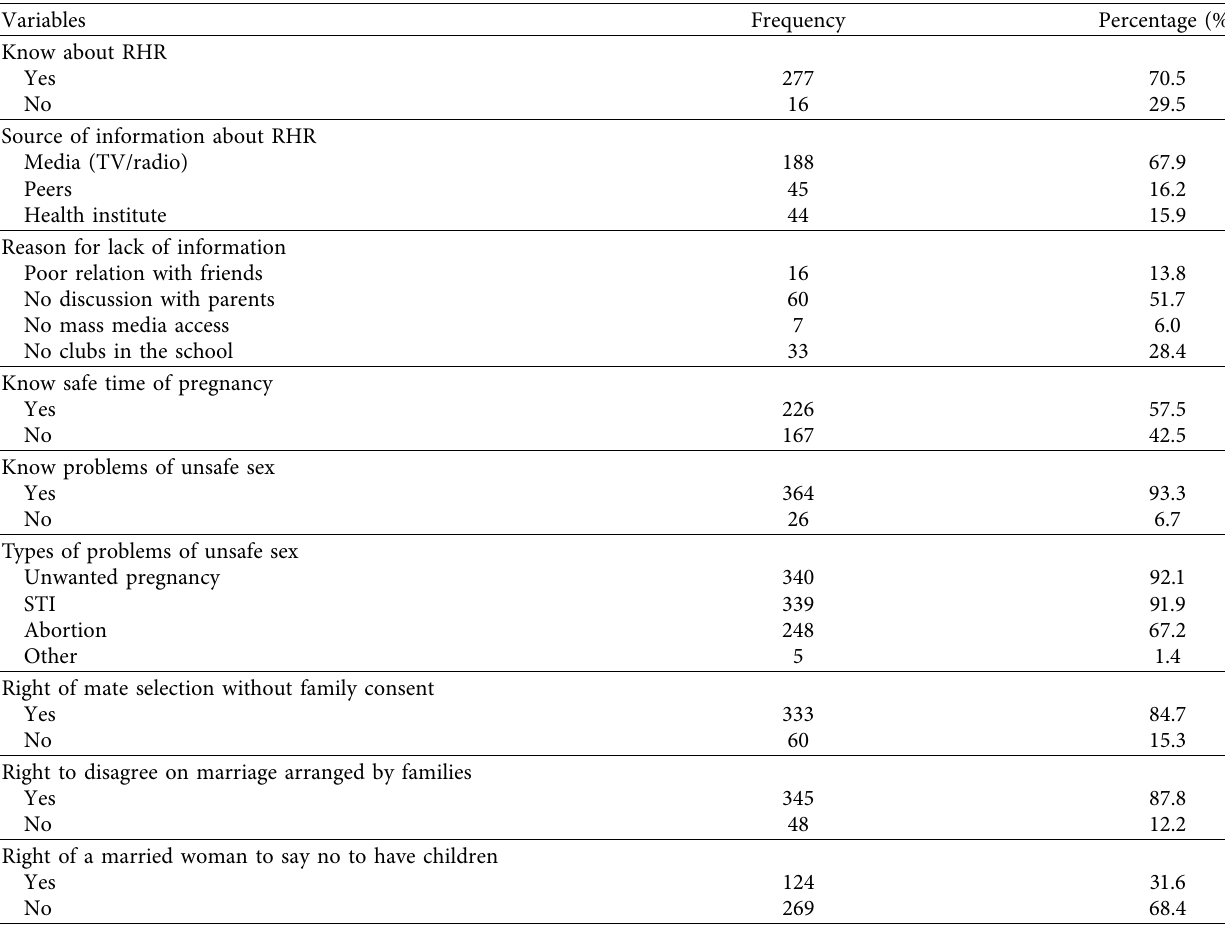
Table 2: Knowledge of sexual and reproductive health right among preparatory school female students, Assela, Ethiopia, 2015.